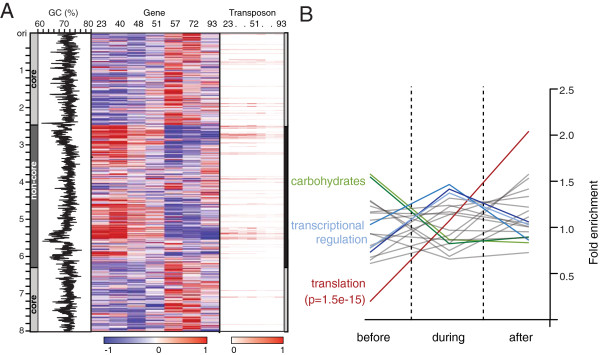
Genome architecture. (A) Heatmap indicating the switching of core (grey) and noncore (dark grey) transcriptional macro-regions during fermentation as follows: black histogram (left panel) shows % of GC with low GC demarcating region border; gene expression (left/middle panel (red and Blue); centred to mean) and transposon expression (red right panel). Together gene expression and transposons show a structured genomic organisation relative to macro-region architecture. (B) Two alternative genetic programs are demarcated at the switch by a bottleneck event that is readily apparent in transcriptomic data. Significant enrichment for functional gene categories at different stages of the growth cycle is indicated.